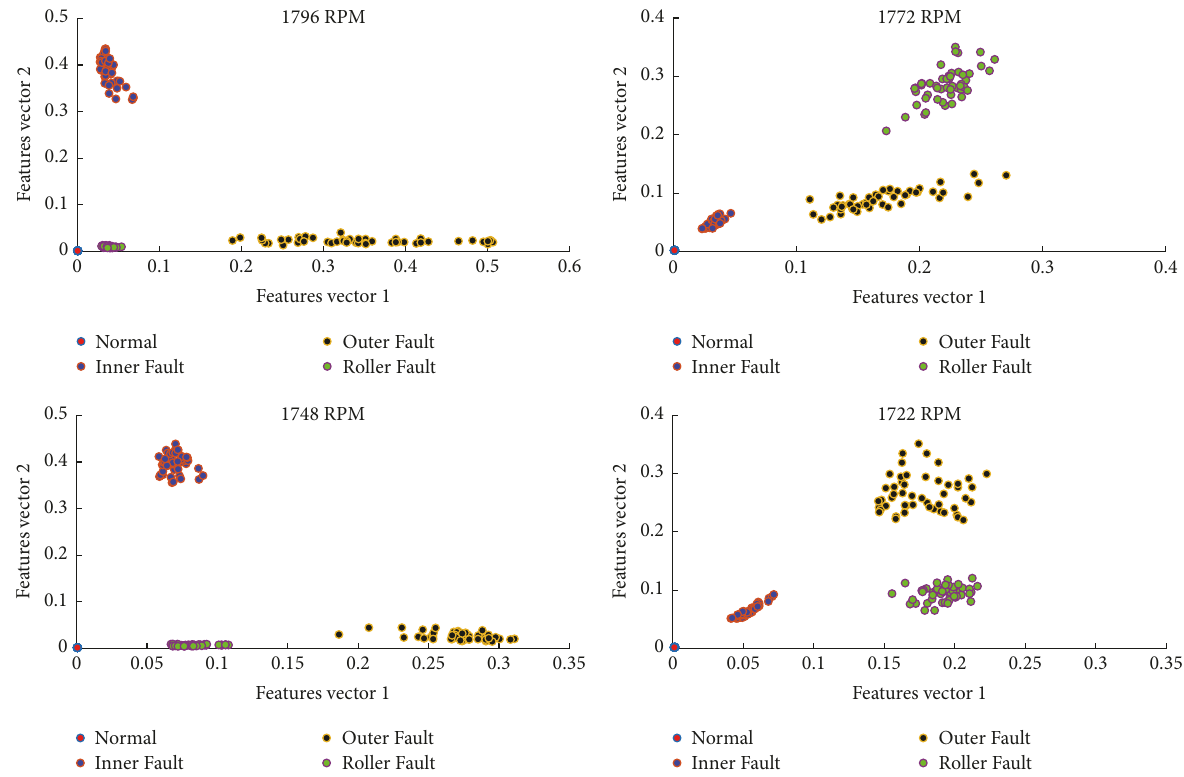
Figure 8: Scatter plots of the features extracted by stacked autoencoders for different shaft